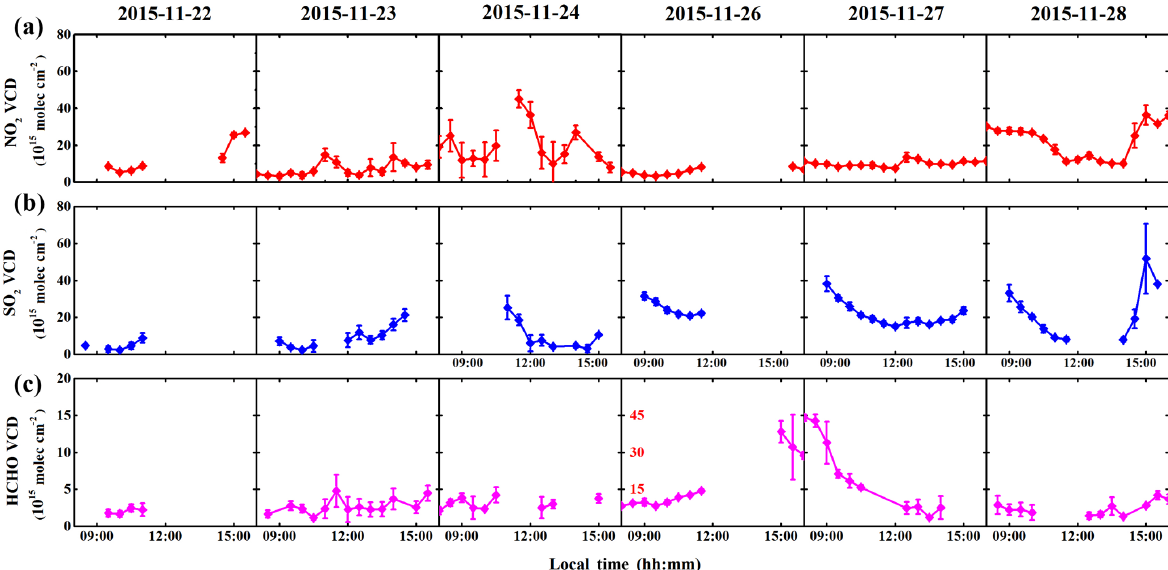
Figure 3. Time series of tropospheric NO 2 (a) , SO 2 (b) , and HCHO (c) vertical column densities (VCDs) from 22 to 28 November. The error bars refer to the 1 σ variation of the measurement. Note that the data were 30min averages, and individual measurements taken under unfavorable wind directions were filtered before averaging. No data are presented for 25 November due to frequent power outages. The y axis scale of HCHO on 26 November is different ( y axis scale in red).